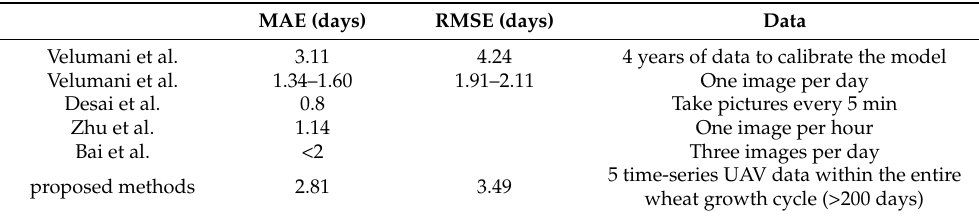
Table 7. The accuracy and the data used compared to previous